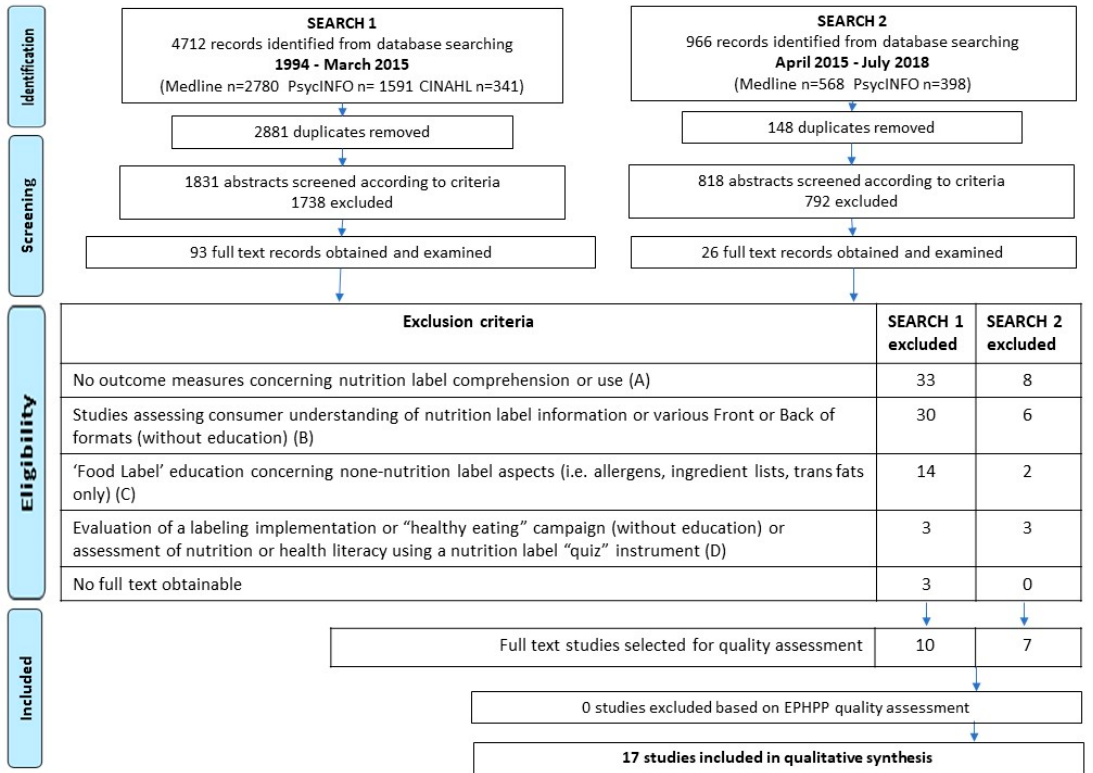
Figure 1. Study selection of articles included in the review. EPHPP: Effective Public Health Practice